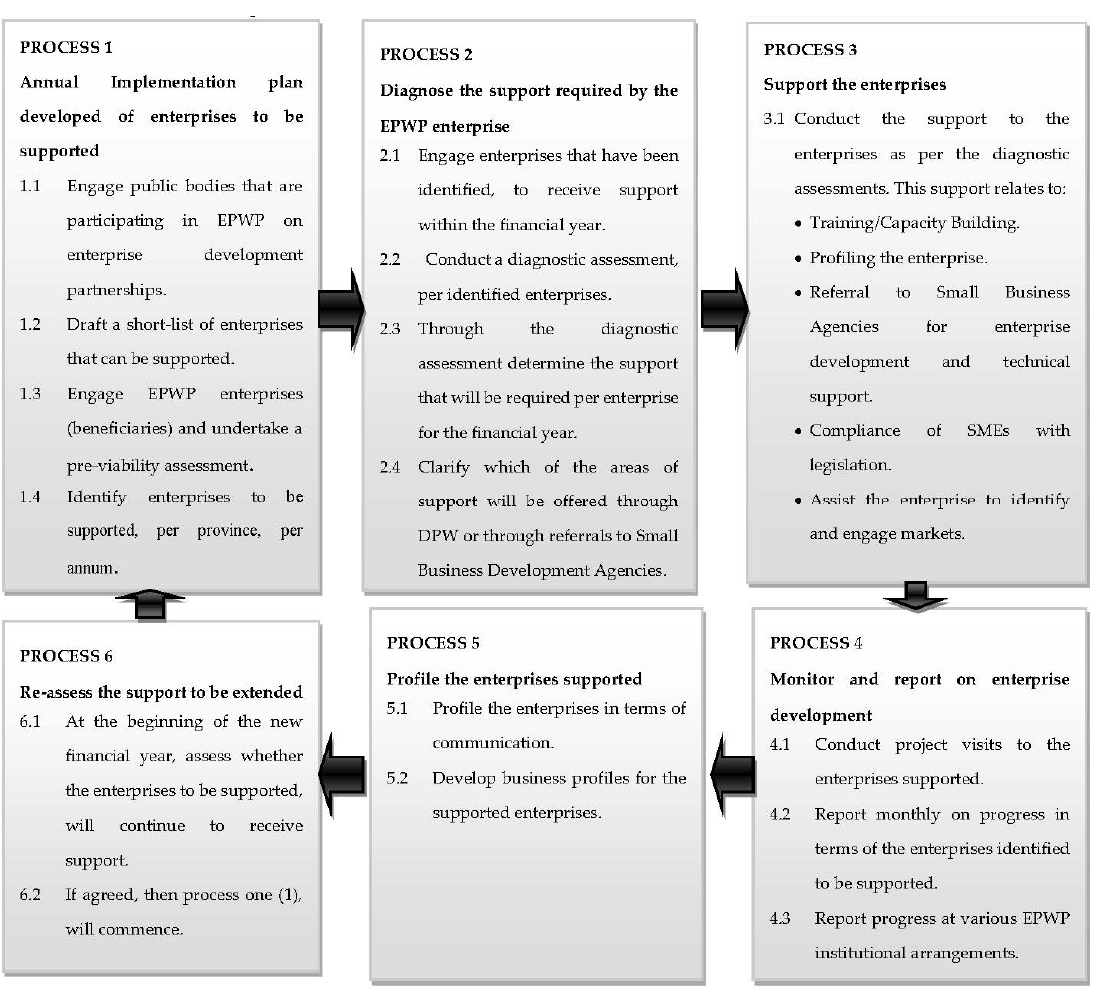
Figure 1. The EPWP Enterprise Development Support Model. Source: EPWP policy on small, medium, and micro enterprises, (EPWP 2013).